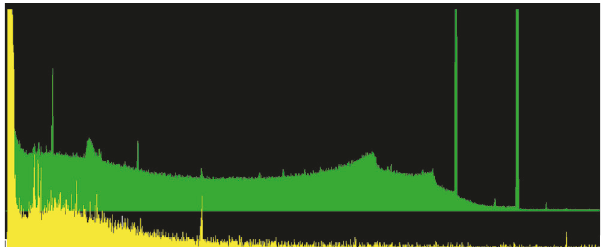
Figure 7: The comparison of 𝛾 spectrums between NaOH aqueous solution and graphite residue (the green for the residual powder, the yellow for the NaOH solution).